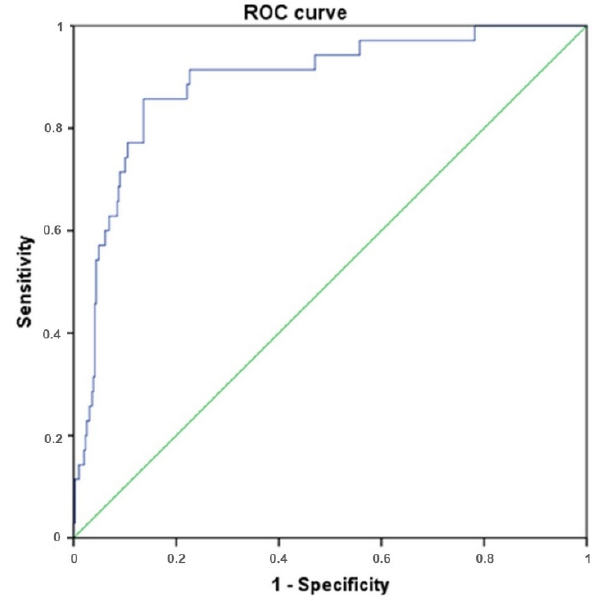
Figure 4. The ROC curve for the overall regression model. AUC is 0.89, which corresponds to the excellent quality of the model. Table 4. The results table for the final overall regression model.